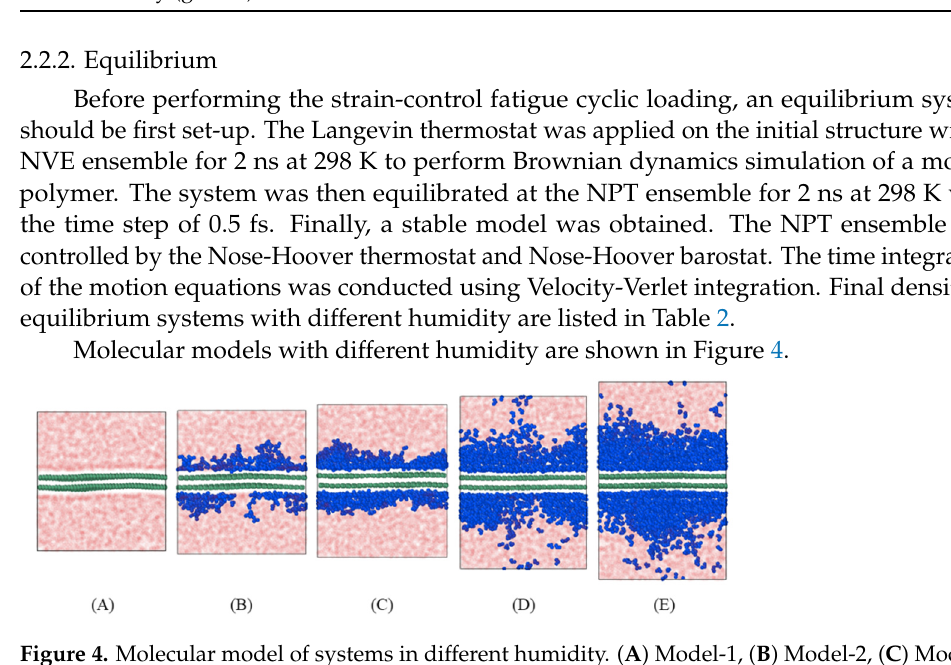
Figure 4. ( A ) Model-1, ( B ) Model-2, ( C ) Model-3, ( D ) Model-4, and ( E ) Model-5. Epoxy resin in light red, graphene in green, and water in blue.